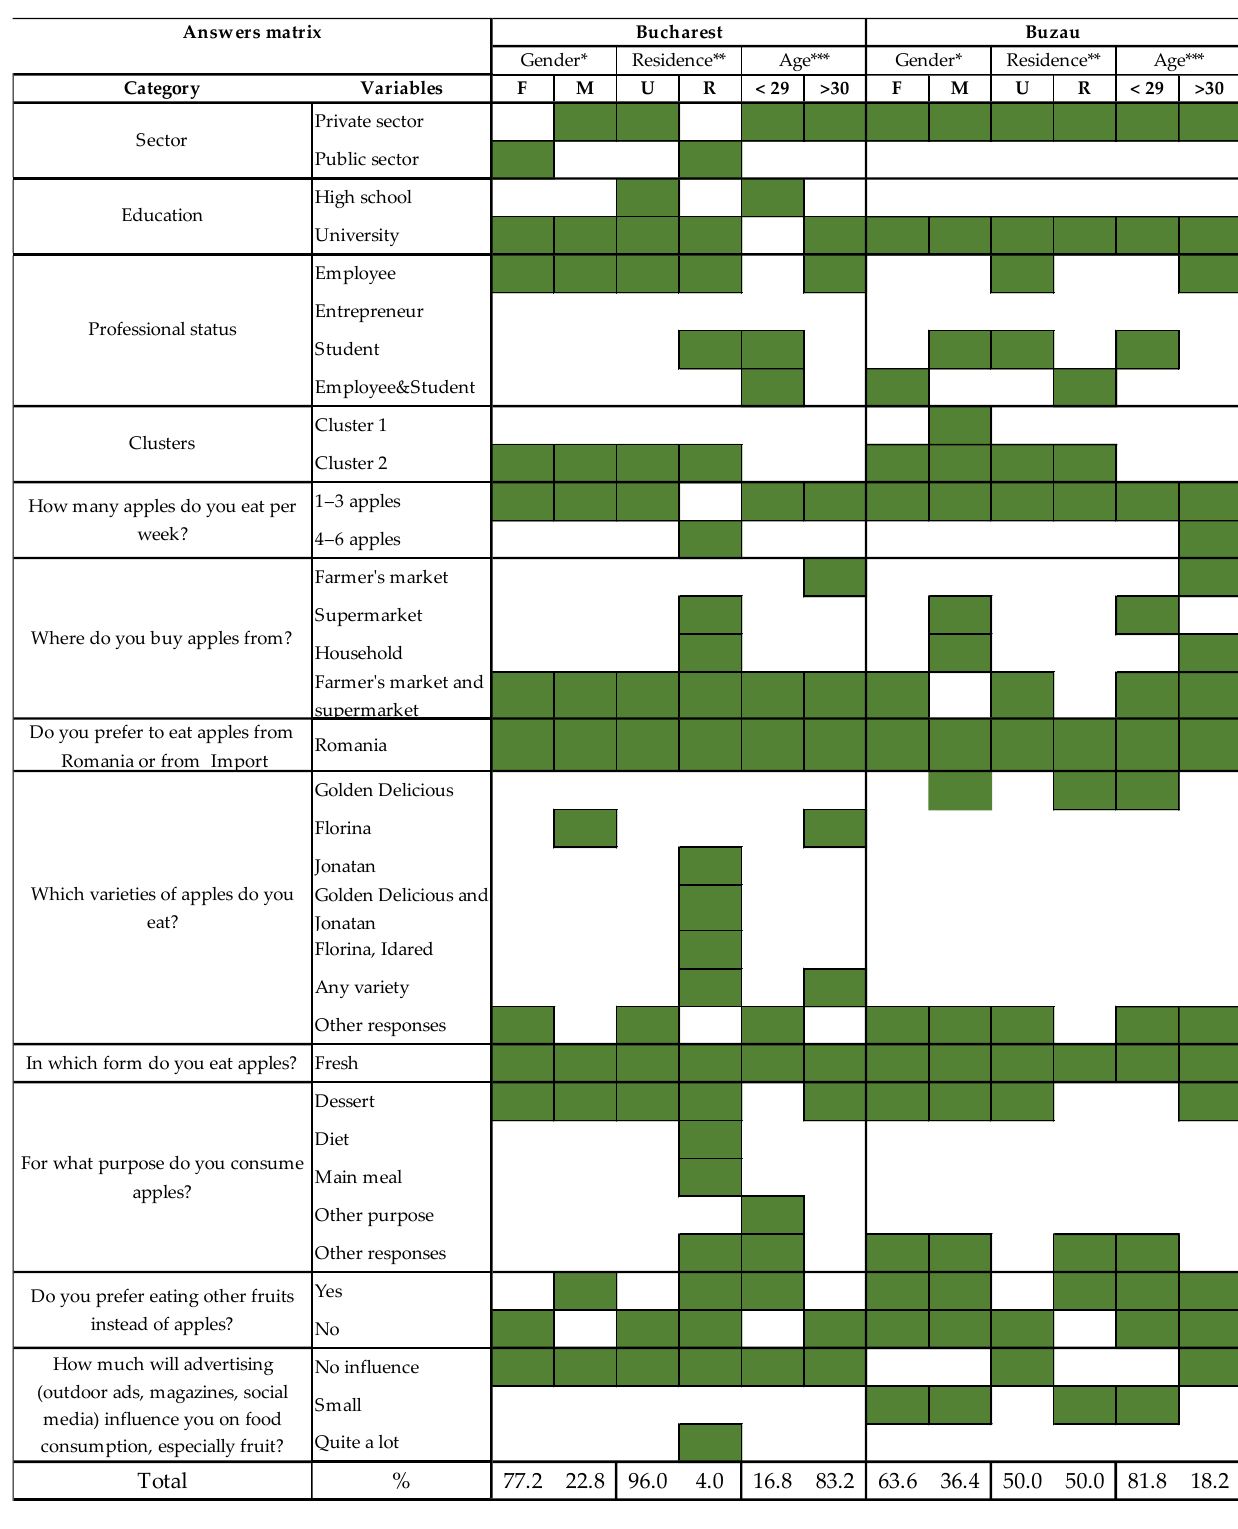
Figure 3. The matrix of the frequencies for the two areas (Bucharest and Buzău). *F–females, M– males; ** U–urban, R–rural; *** <29–under 29 years old, >30–over 30 years old. Source: own representation based on the survey responses.